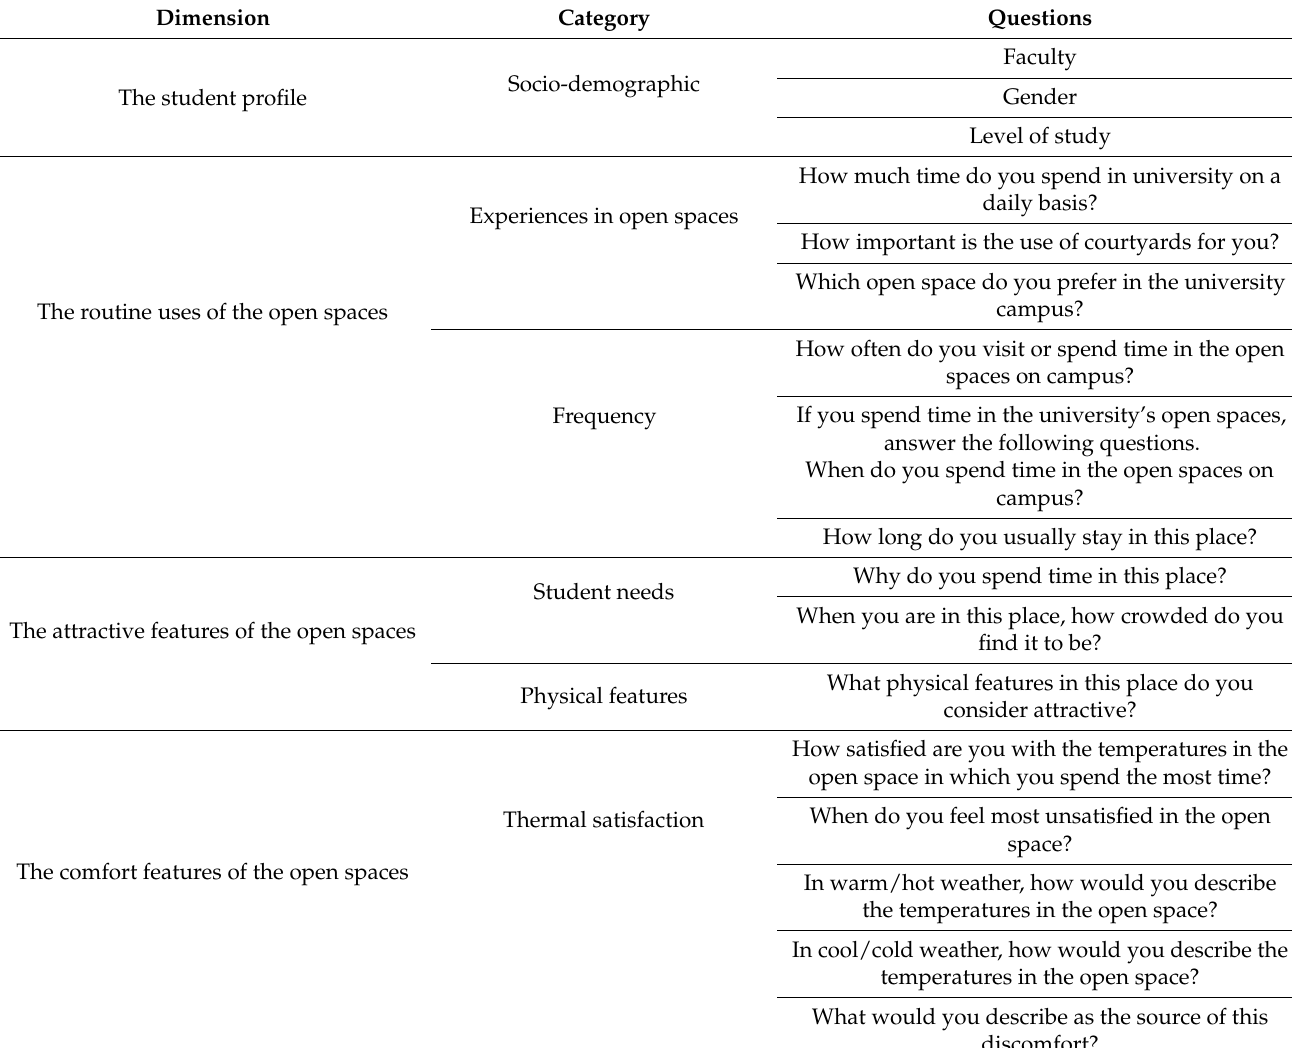
Table 4. The questionnaire structure (dimensions, categories, and